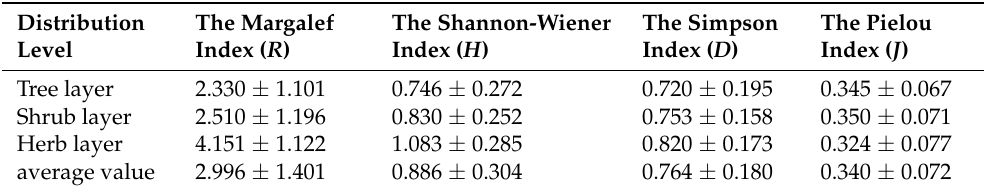
Table 8. Species diversity index of overall plant community in traditional villages in karst topographic regions of the Zunyi City.